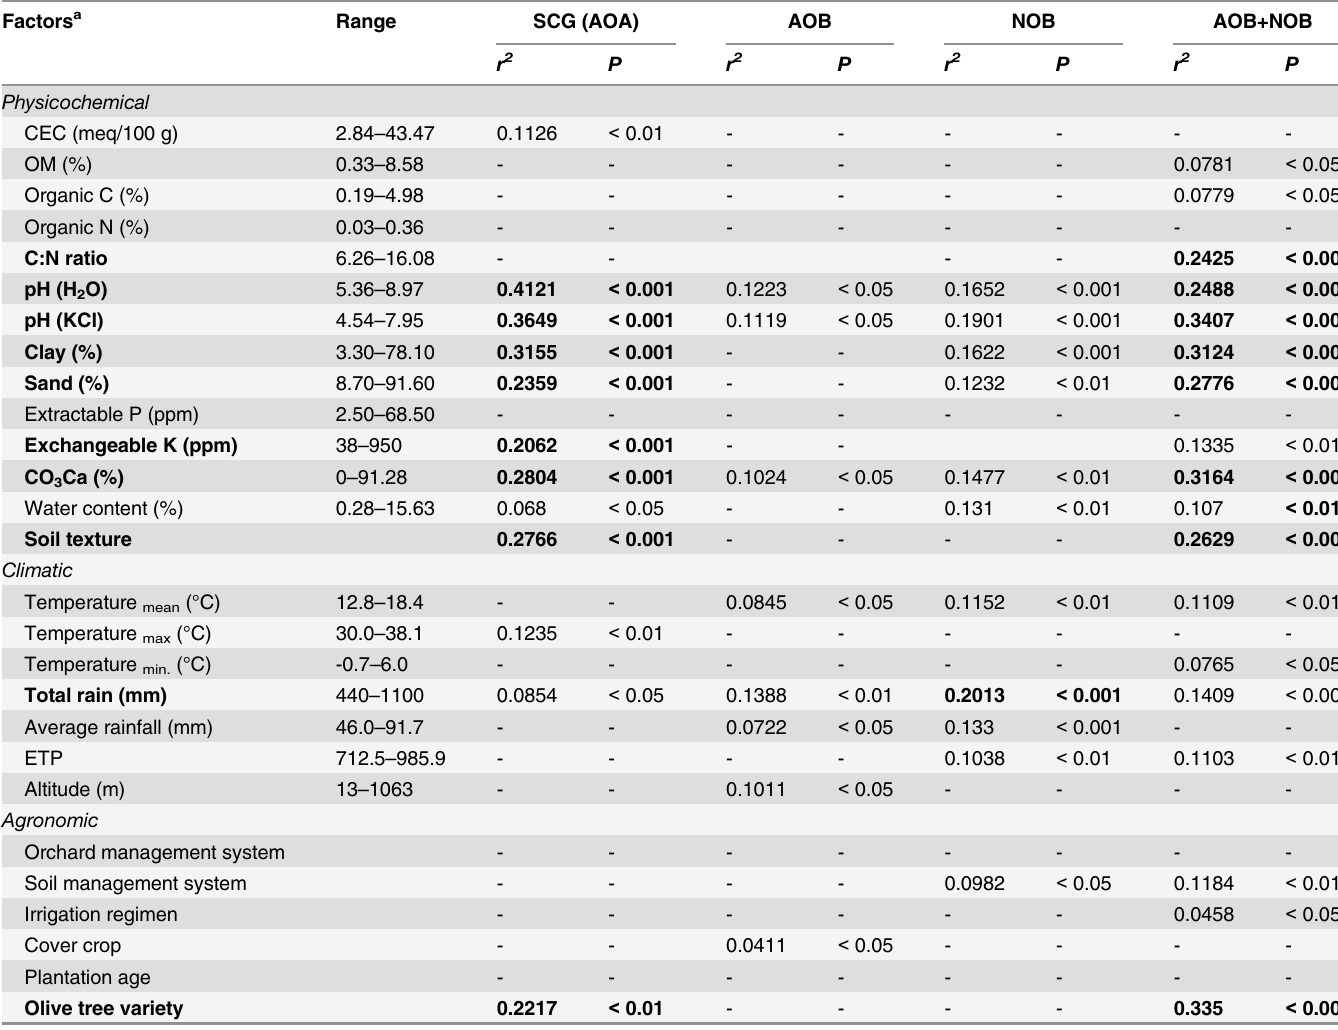
Table 2. Summary of relationships between environmental factors (explored range of values are also shown; see also Table 1) and SCG (AOA), AOB and NOB microbial assemblages composition from the rhizosphere of olive